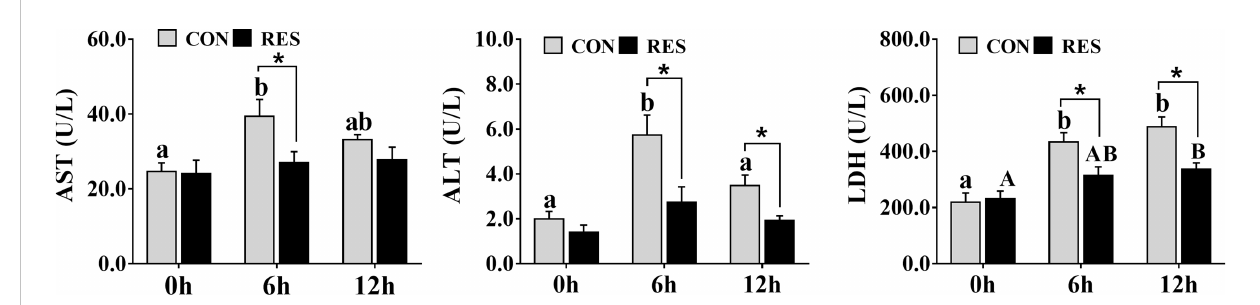
FIGURE 1 Effect of dietary RES on plasma AST, ALT, and LDH activities in gibel carp at 6 h and 12 h after LPS injection. Data are mean ± SEM (n = 6). The lowercase letters represent signi fi cant differences among diverse LPS durations in the CON group ( P < 0.05); the uppercase letters represent signi fi cant differences among diverse LPS durations in the RES group ( P < 0.05). * ( P < 0.05) represent signi fi cant differences between the CON and RES